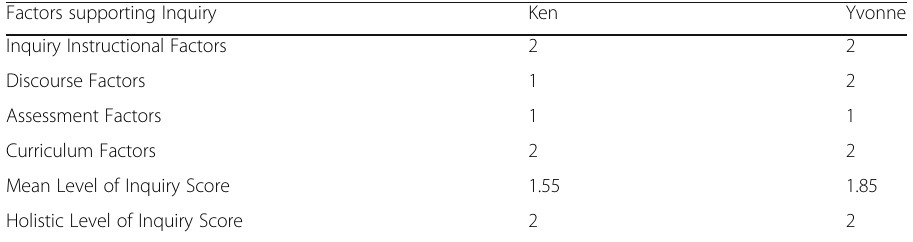
Table 2 Holistic score of teachers Factors supporting